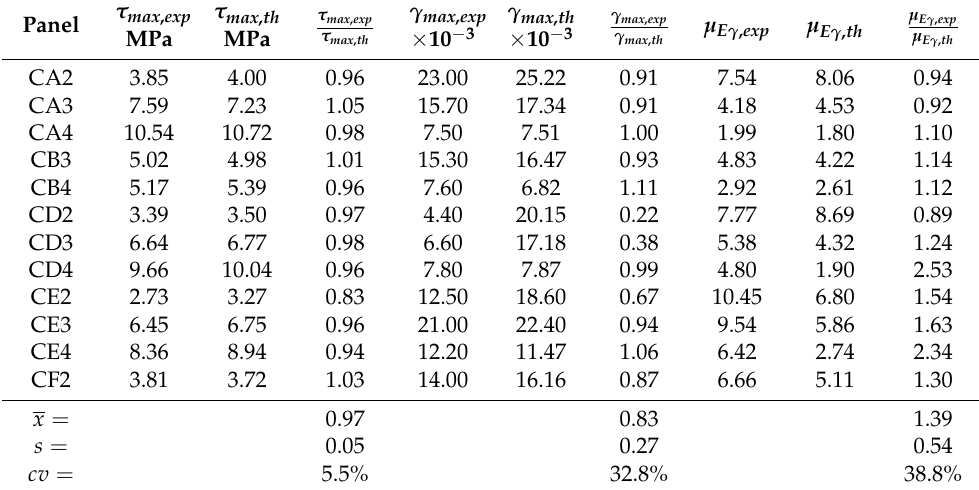
Table 3. Comparative analysis: positive (+) loading shear direction (peak point and ductility).